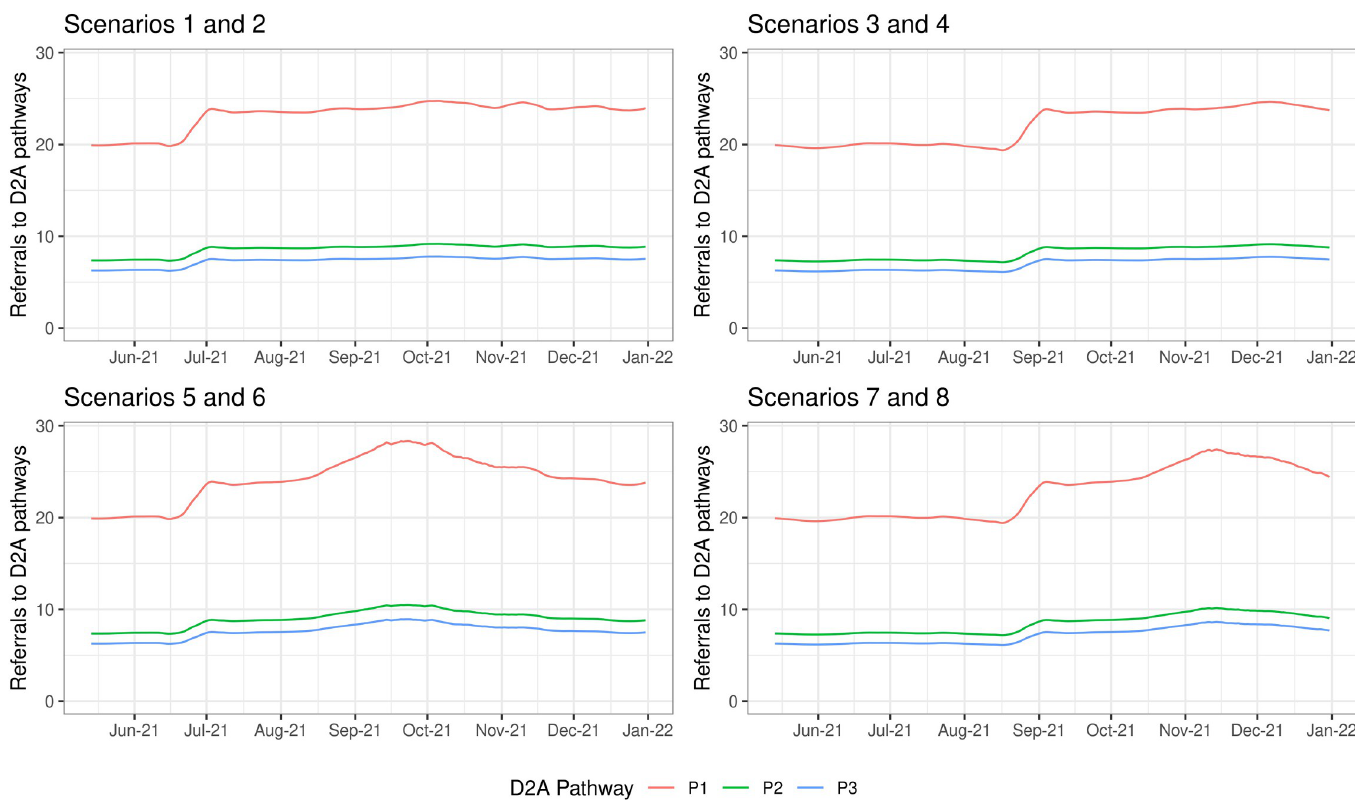
Fig 2. Projections of demand for intermediate care Discharge to Assess (D2A) pathways P1-3, for each of the considered scenarios.